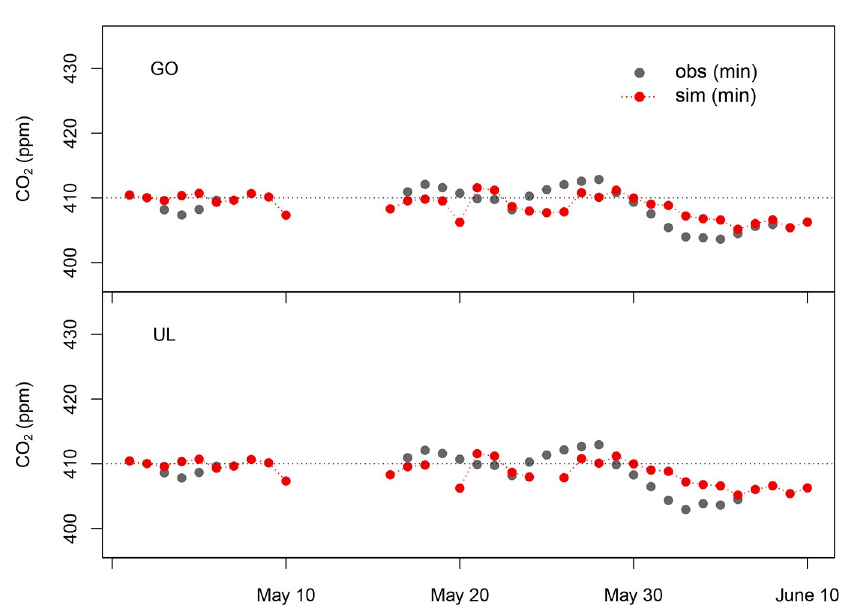
Fig 3. 5-day moving average of observed and simulated daily minimum CO 2 concentrations at GO and